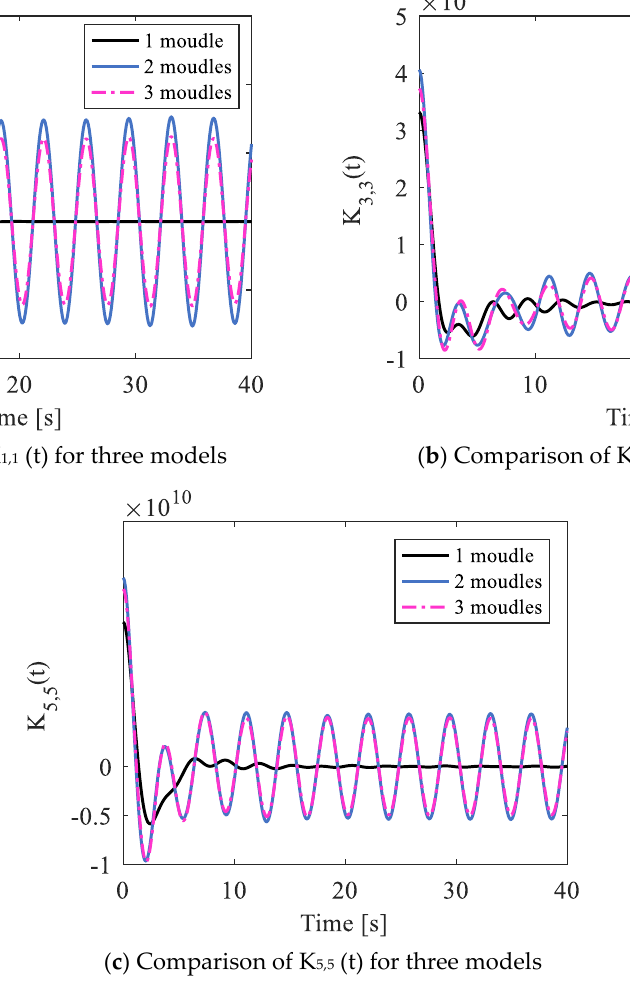
Figure 12. Comparison of the calculated impulse response function K(t) for the windward module with different module numbers.